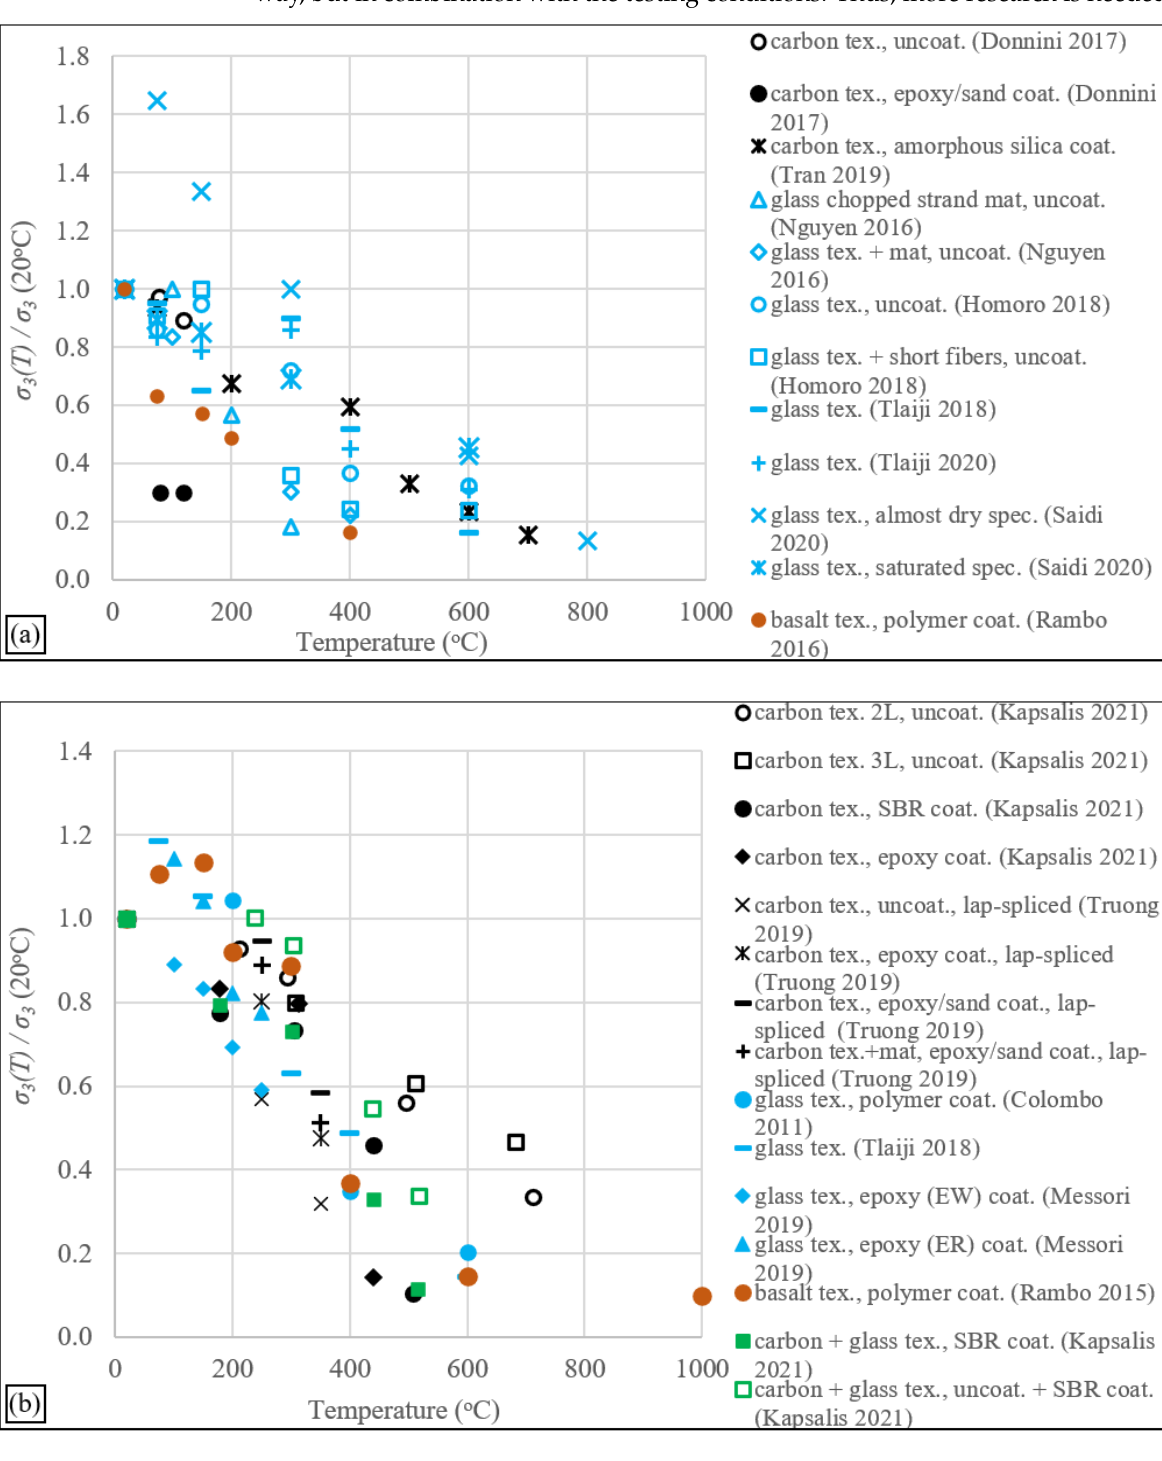
Figure 5. Ultimate stress ( σ 3 ) versus exposure temperature for various TRC compositions; ( a ) specimens loaded while in heated conditions; ( b ) specimens tested after cooling down.